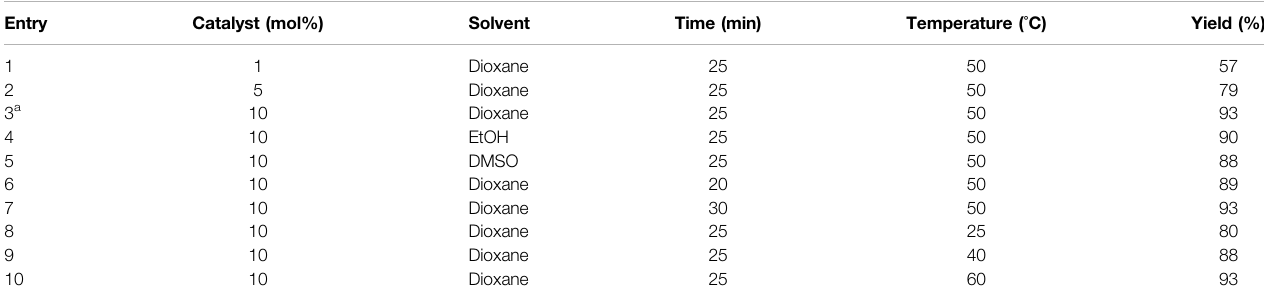
TABLE 2 | Optimization of the reaction conditions (catalyst loading, solvent, reaction time, and temperature) for the synthesis of compound 6a .